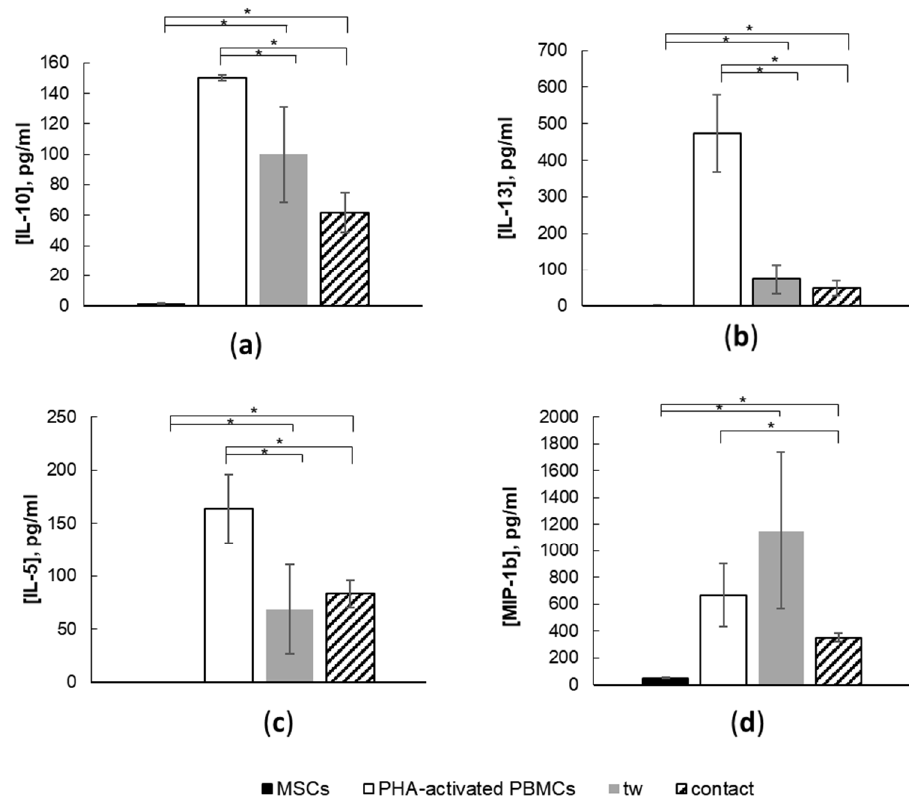
Figure 7. Production of ( a ) IL-10, ( b ) IL-13, ( c ) IL-5, and ( d ) MIP-1b by activated PBMCs is inhibited in contact and non-contact (tw) co-cultures with MSCs. Data are shown as mean ± std; n = 5, t -test, * reliability of differences at p < 0.05. Contact refers to contact MSC–PBMC co-culture, tw refers to non-contact co-culture. Five unrelated donors per cell type were used.